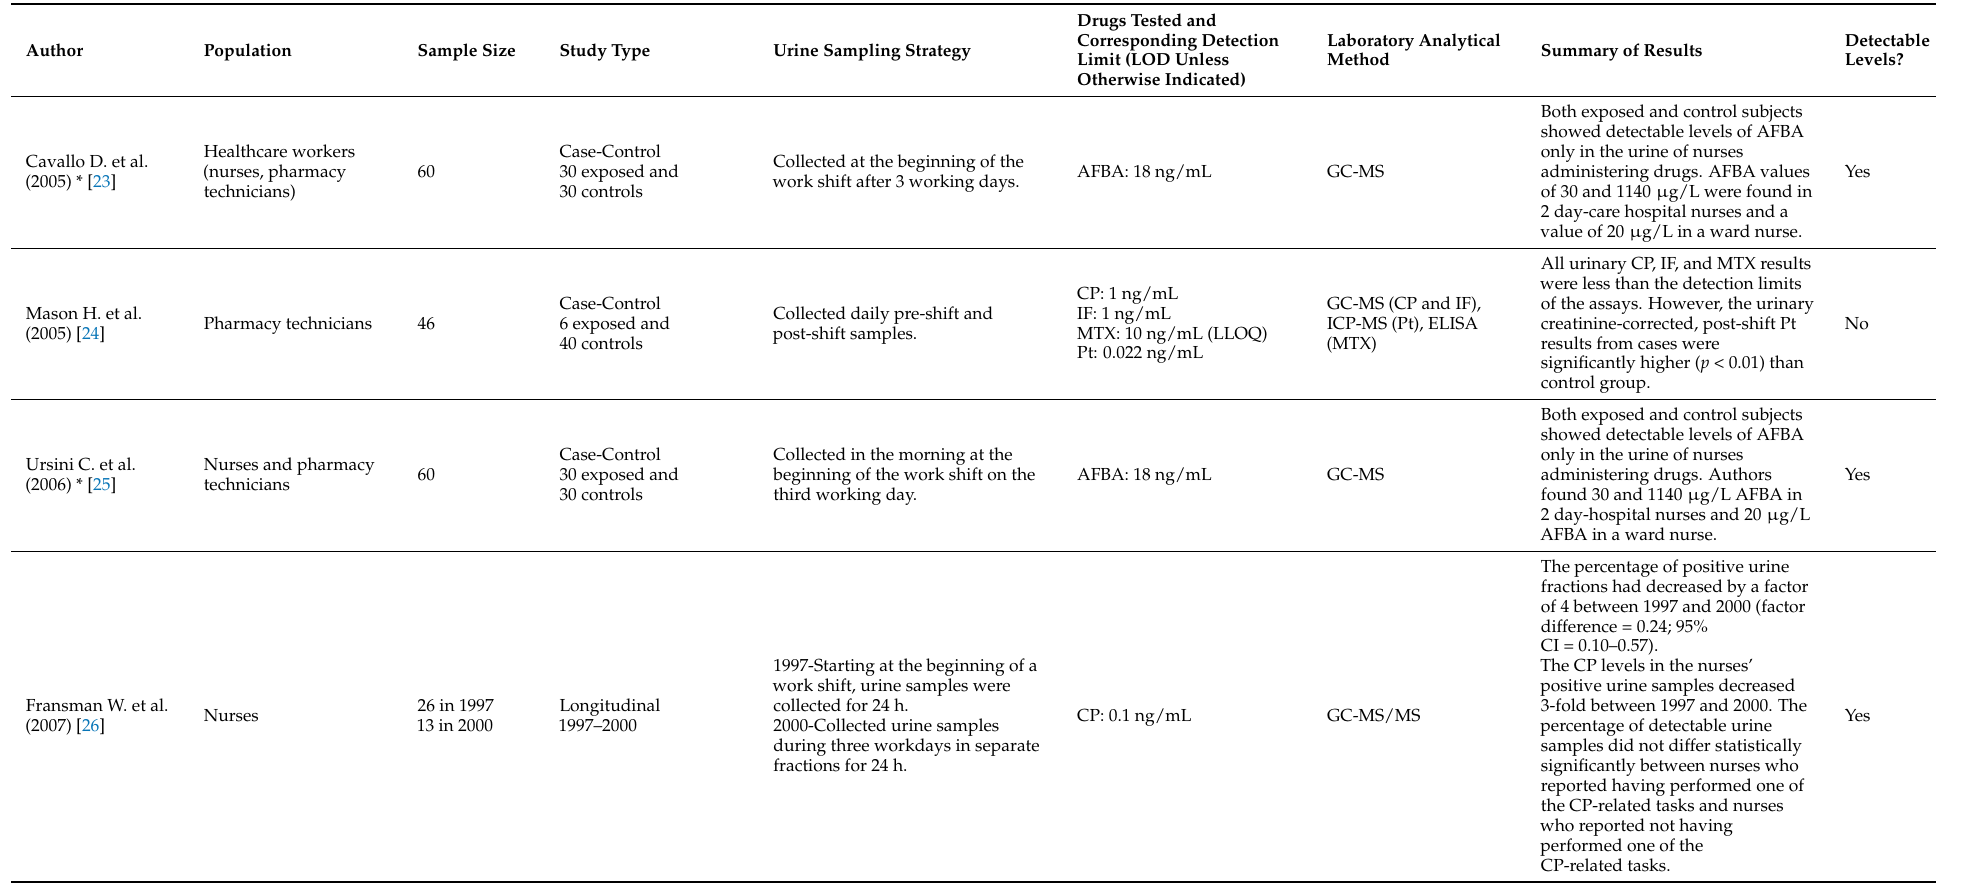
Table 1. Summary of articles in which urine samples were collected for biomonitoring of hazardous drugs, arranged in chronological